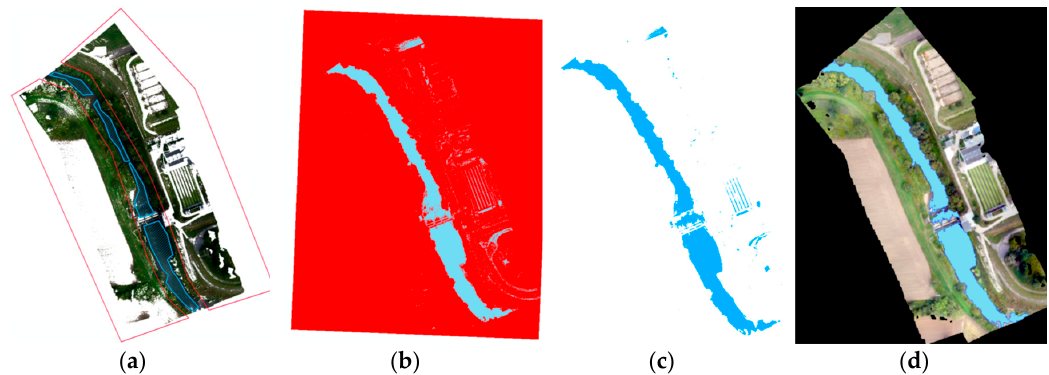
Figure 3. An example of the processing according to the supervised classification strategy: ( a ) the training samples for classification, ( b ) the classification results, ( c ) the class Water after applying the modal filter for the raster format and the conversion into a vector format, and ( d ) the final results of the classification (blue area) filtered using an SQL query and projected the over input image.